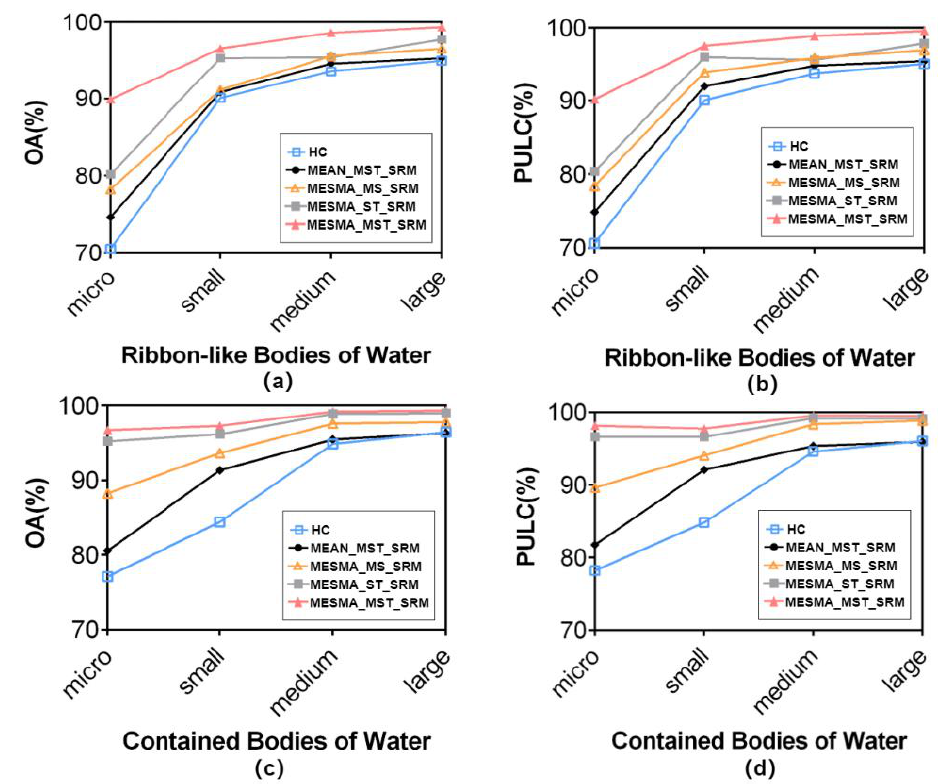
Figure 6. Accuracy analysis of different types of water: ( a ) OA for ribbon-like bodies of water; ( b ) PULC for ribbon-like bodies of water; ( c ) OA for contained bodies of water; ( d ) PULC for contained bodies of water.